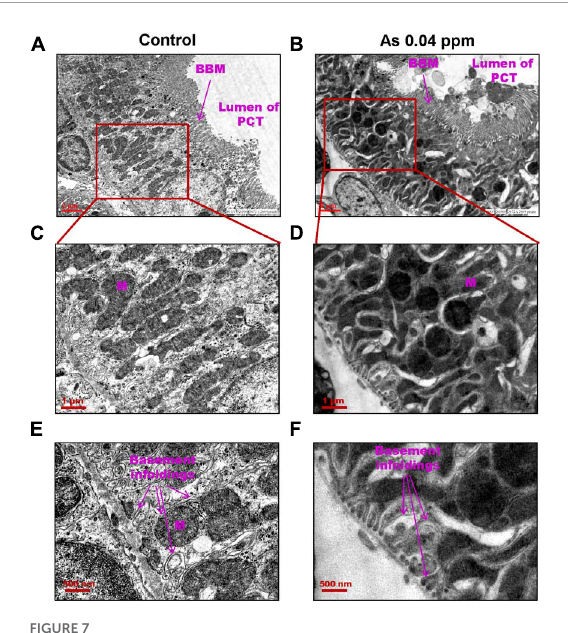
FIGURE7 Prenatal As exposure leads to ultrastructural damage in PCT. TEM analysis showed increased mitochondrial damage. The damage in the mitochondrial membrane and its cristae are prominent in kidneys isolated from 38 weeks old prenatally As exposed animals. Furthermore, damage in basement infoldings was also observed (C–F) . The brush border membranes (BBM) are also damaged in exposed groups (A–B) .